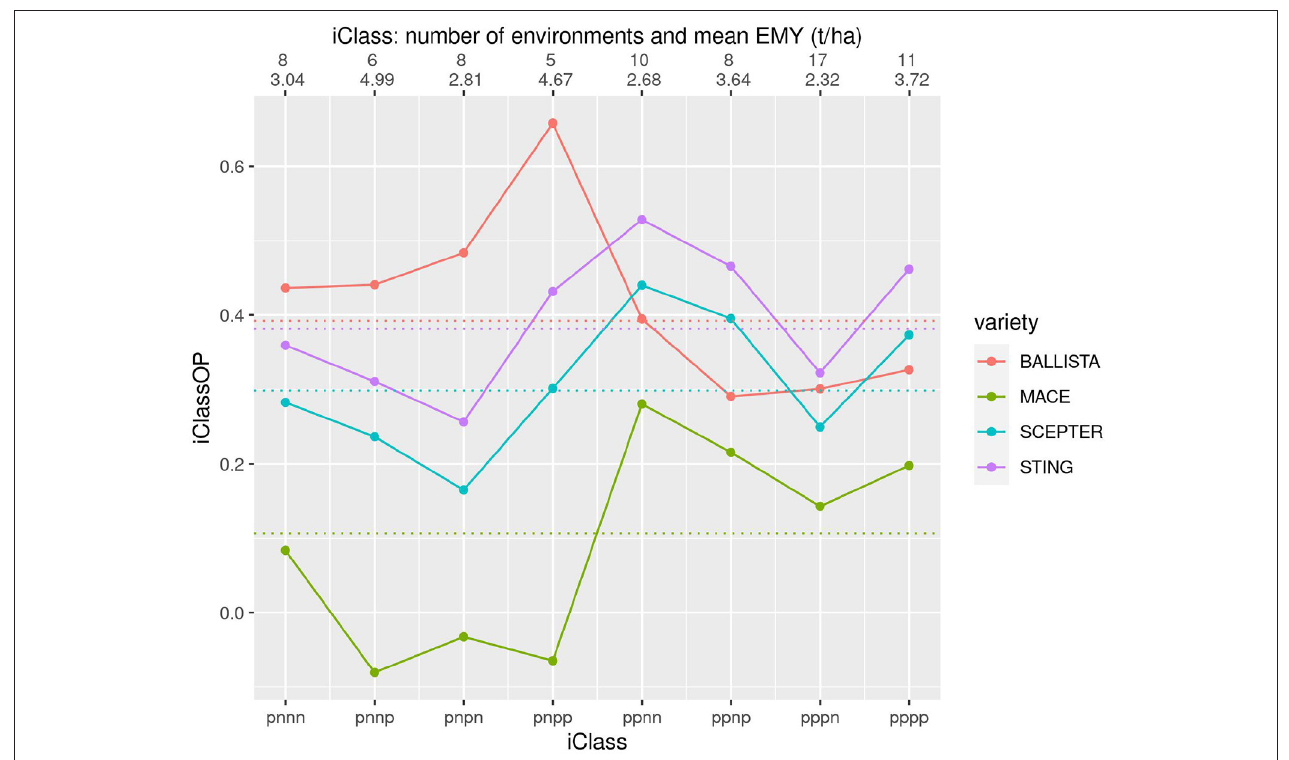
FIGURE 6 | iClass interaction plot for the four varieties BALLISTA, MACE, SCEPTER and STING. The points and solid lines that join them correspond to iClassOP and the dotted horizontal lines correspond to the OP measure of Smith and Cullis (2018). The axis at the top shows the number of environments in each iClass and the mean of the associated environment mean